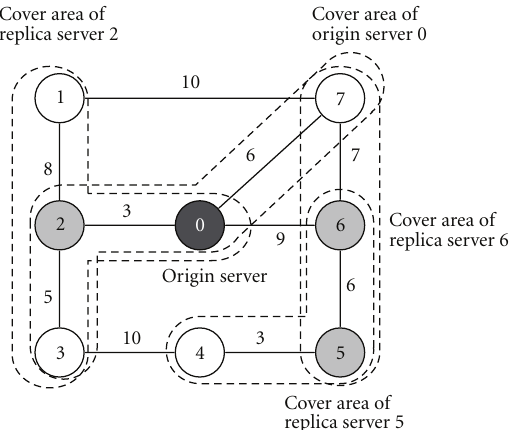
Figure 1: Greedy algorithm cannot obtain the optimal solution, where the distance constraint, q ( u ), is 8. The number of replica servers is 3.